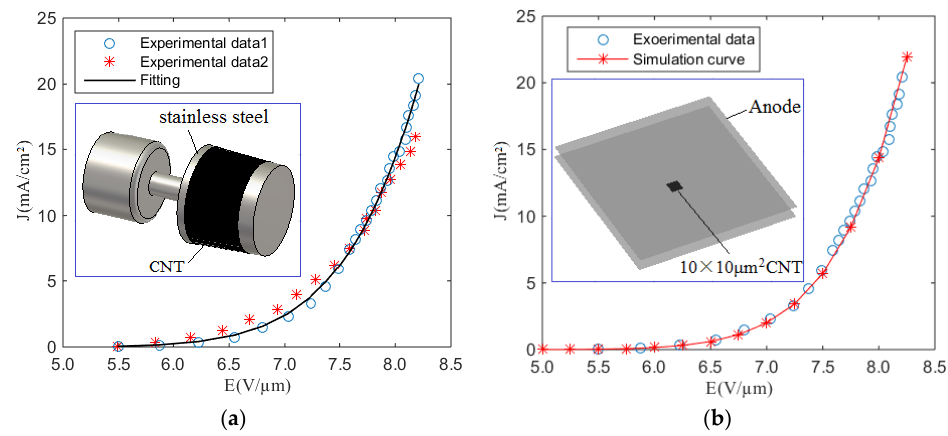
Figure 1. Fitting, simulation, and experimental results. ( a ) Fitting and experimental current density as a function of global electric field. Inset: Scheme depicting the truncated-Spindt carbon nanotube cold cathode electron source. ( b ) Simulation and experimental for a generalized square emitter confirming the commutability of the Fowler–Nordheim (FN) coefficient extraction processed outlined. Inset: simulation geometry.